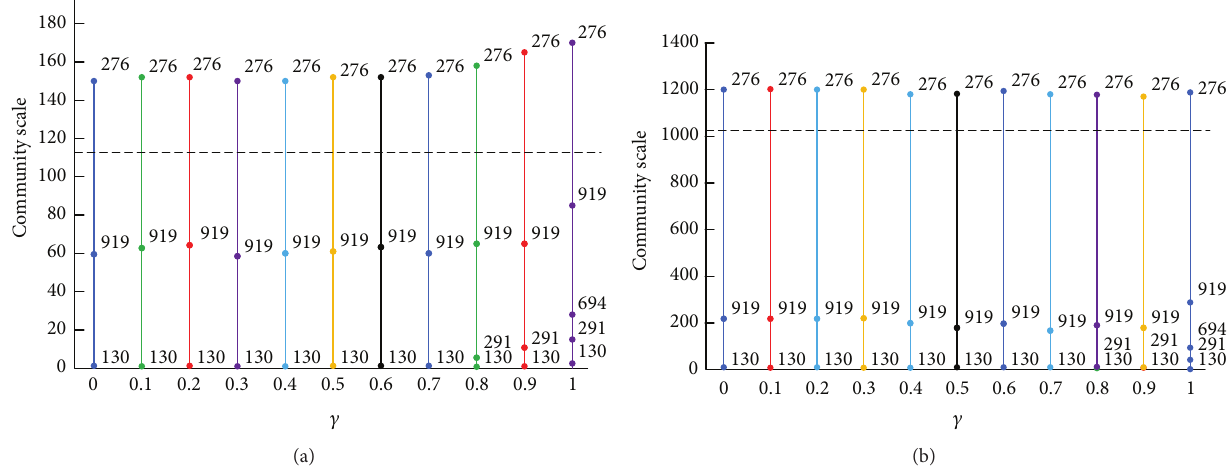
Figure 3: The community division result of MovieLens data set starting from user nodes. Related instructions are shown in Figure